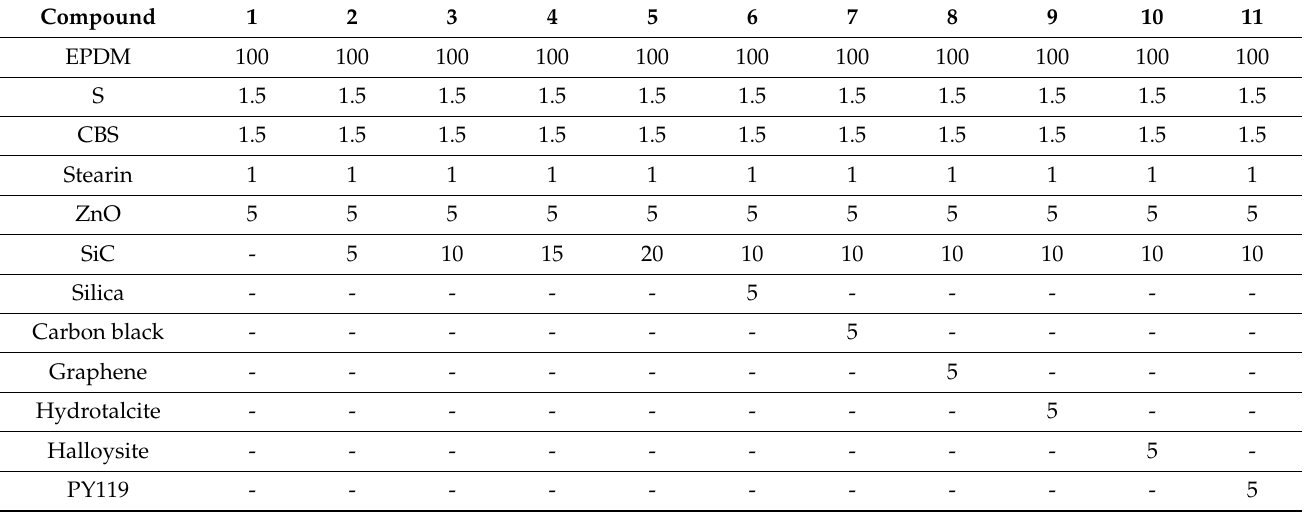
Table 1. Composite